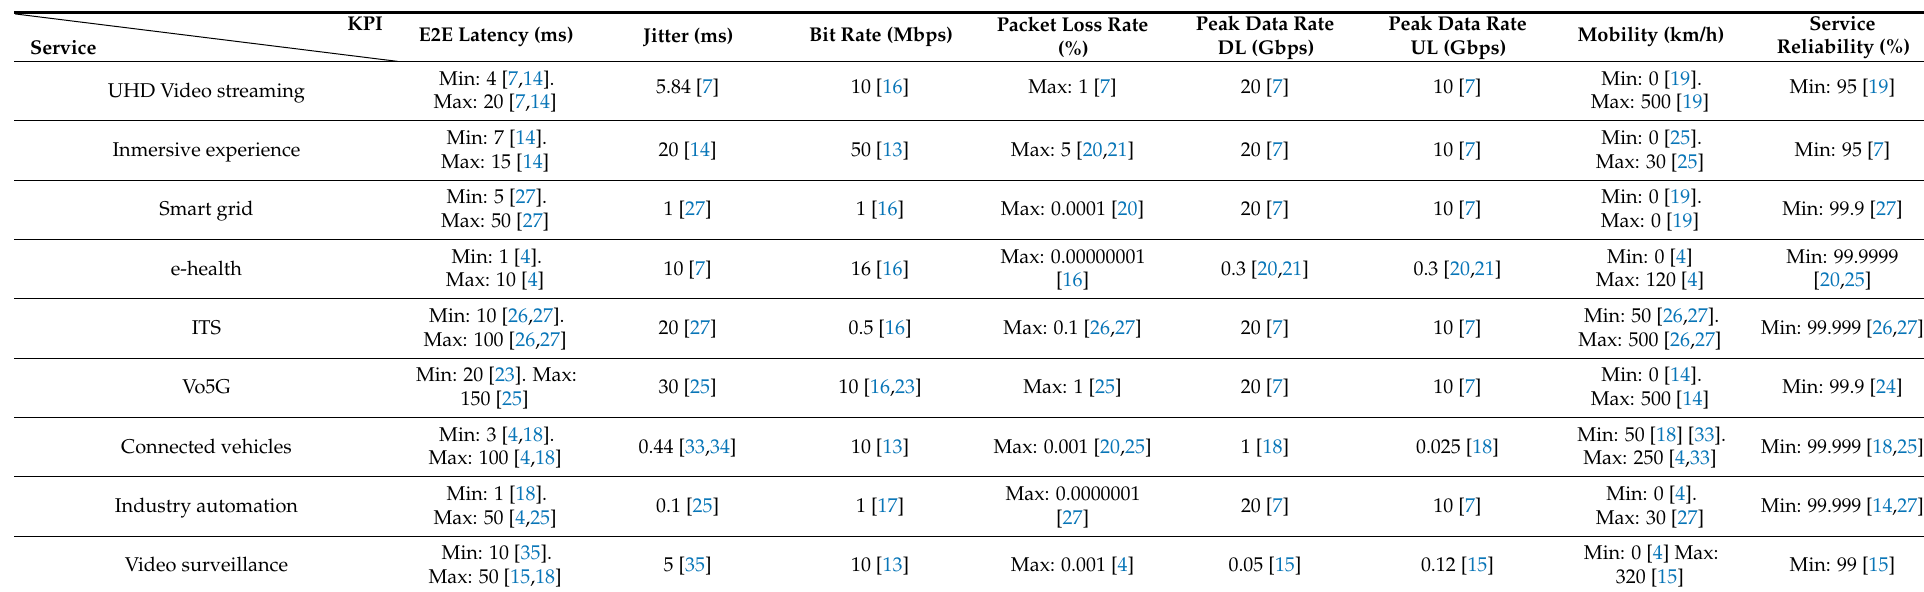
Table A1. 5G service KPI